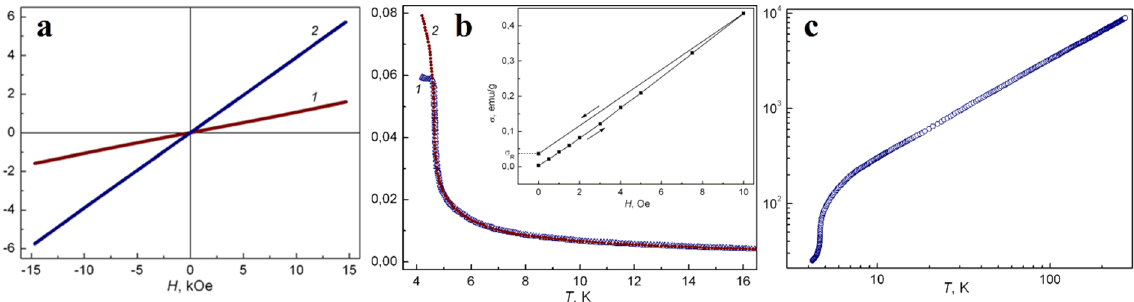
Figure 6. Experimental magnetic curves for the EuErCuSe 3 sample. ( a ) Magnetic field dependences of the magnetization, at temperatures 293 K (1) and 85 K (2). ( b ) Temperature dependences of the magnetization, recorded in the ZFC (1) and FC (2) modes. H = 2 Oe. The inset shows a fragment of a particular hysteresis loop at T = 4.2 K. ( c ) Temperature dependence of the inverse magnetic susceptibility. H = 10 Oe.